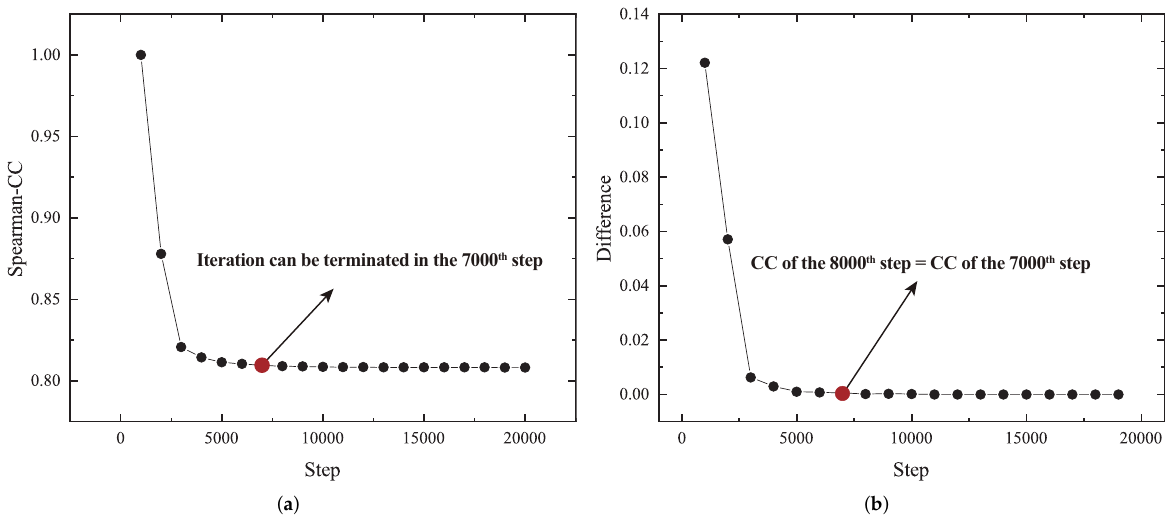
Figure 14. The statistical results after the excavation of the 9# and 10# coal seams. ( a ) The relationship between the Spearman-CC and step, ( b ) the relationship between inter-step difference and